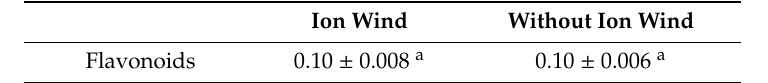
Table 3. Flavonoid content under ionic wind and without ionic wind (g / 100 g).